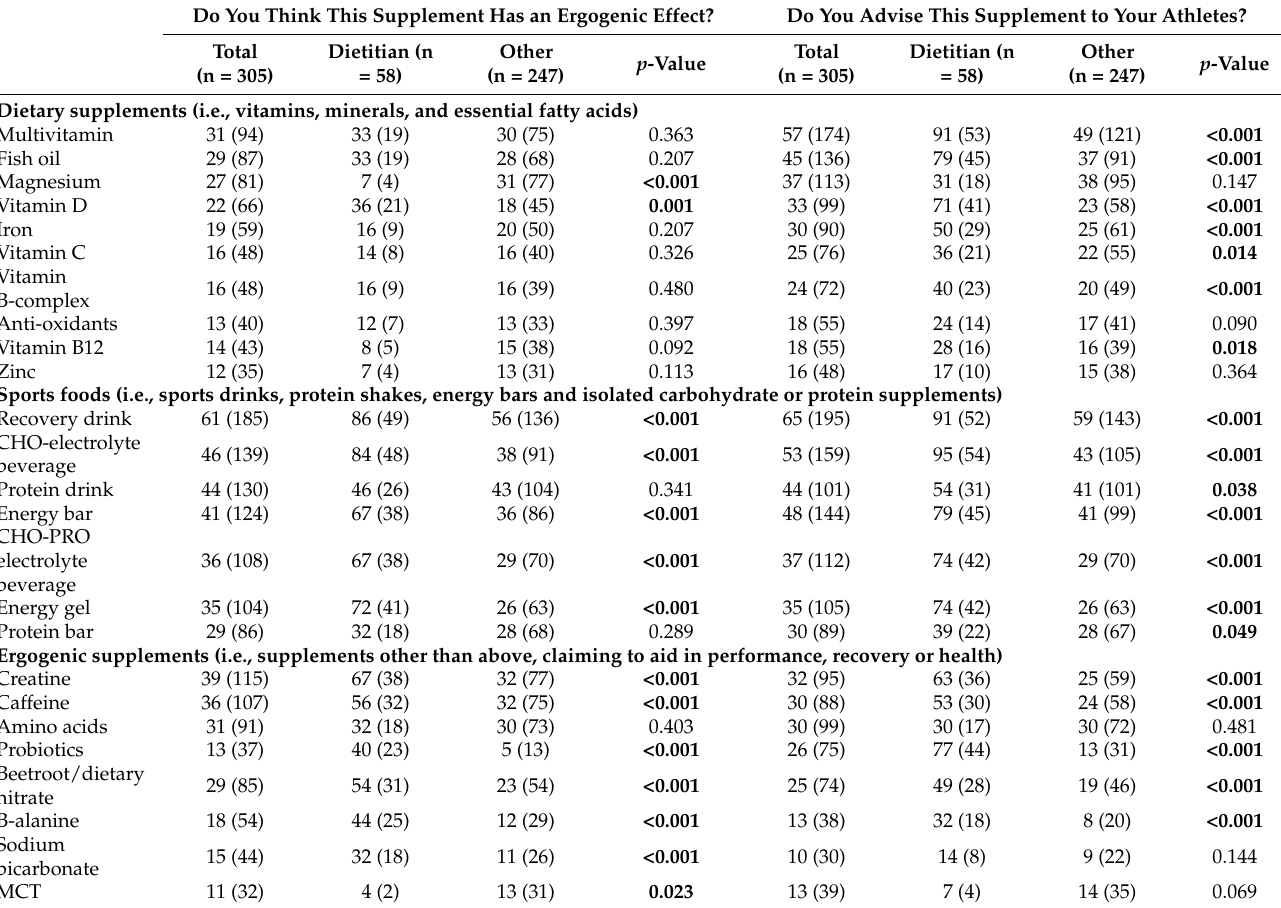
Table 6. Ergogenic effect and advising of nutritional supplements by sports health